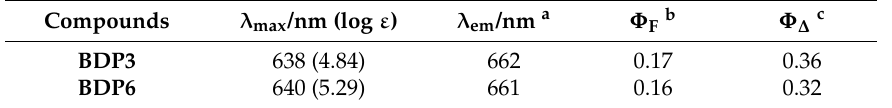
Table 1. Photo-physical/photo-chemical data of BDP3 and BDP6 in DMF. Compounds